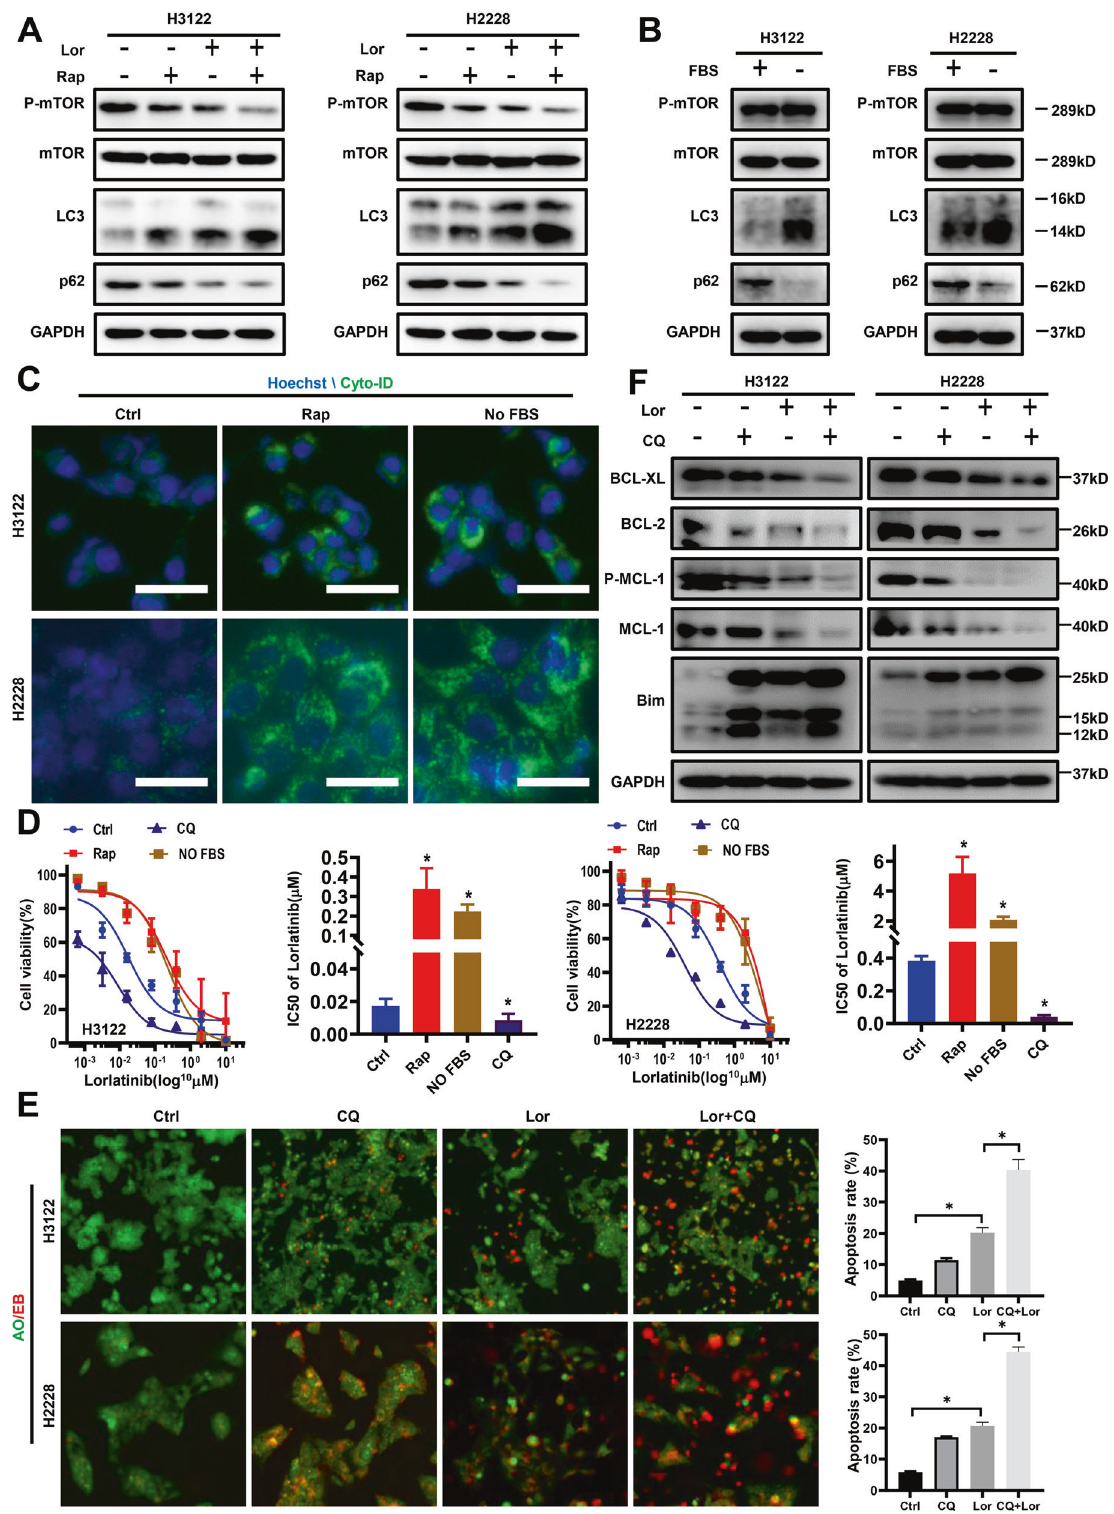
Fig. 3 Lorlatinib-induced autophagy protects cells from apoptosis. A Cells were treated with lorlatinib (10 nM) with or without rapamycin (500 nM) for 48 h and observed changes in the content of LC3, p62, p-mTOR and total mTOR. B Western blot analysis of cells treated with or without fetal bovine serum (FBS) for 48 h. C Fluorescence photographs were shown the autophagosomes of H3122 and H2228 cells, which were treated with Rap (500 nM) or serum deprivation. Scale bar is 40 μ m. D Cell viability CCK-8 assay for cells treated with the indicated concentrations of lorlatinib with or without CQ/ rapamycin/FBS for 48 h. * P < 0.01 compared with control. E Cells were treated with lorlatinib with or without CQ for 48 h, then stained with AO/EB. * P < 0.01. F Cells were treated by lorlatinib with or without CQ for 48 h. Western blot analysis was performed on the Bim, BCL-2, MCL-1, P-MCL-1, BCL-XL expression levels. GAPDH was included as a loading control. Lor lorlatinib, CQ chloroquine, Rap rapamycin. Cell Death Discovery (2022)